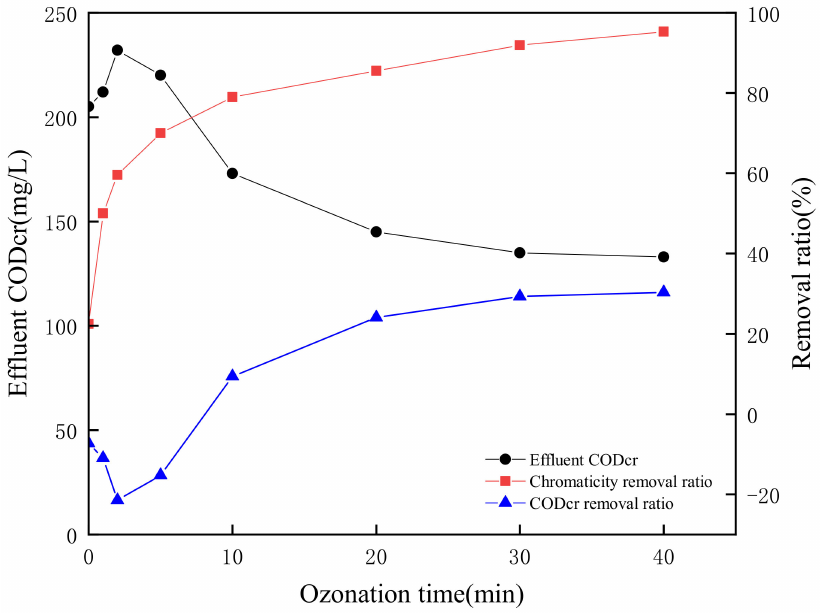
Figure 9. Treatment efficiency of COD Cr and chromaticity under the optimal conditions. Under the optimal experimental conditions, the salicylic hydroxamic acid and min- eralization ratio of the simulated flotation wastewater by O 3 oxidation at different times were analyzed as shown in Figure 10. As the oxidation time extended, the salicylic hy- droxamic acid and total organic carbon (TOC) removal ratio increased. During the first 10 min reaction time, the removal ratio of salicylic hydroxamic acid was more than 80%, but the TOC removal ratio was lower than 15%. When the ozonation time was prolonged from 15 min to 40 min, the salicylic hydroxamic acid increased from 93.94% to 98.16%, and the TOC removal ratio improved from 19.99% to 44.86%. It could be deduced that salicylic hydroxamic acid was easy to be degraded in the process of ozonation, but other intermediate products were stable and difficult to be mineralized completely. Chang et al., detected oxidation byproducts of salicylic acid during the O 3 process, catechol, maleic acid, and oxalic acid were chain compounds, but the mineralization ratio was low